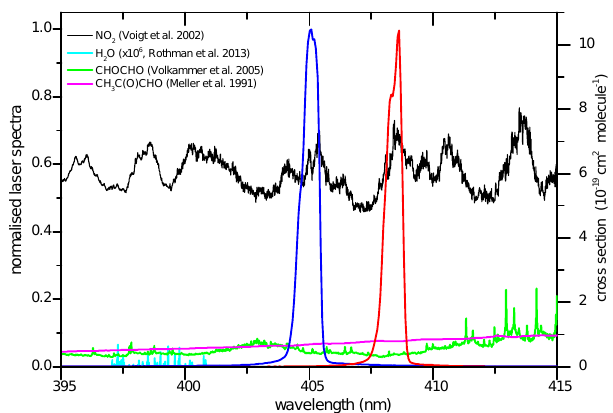
Figure 2. Laser emission spectrum (left y axis) measured in the ref- erence cavity (blue) and the TD cavity (red). The absorption spec- tra (Meller et al., 1991; Voigt et al., 2002; Volkamer et al., 2005b; Rothman et al., 2013) are associated with the right y axis. The H 2 O spectrum is scaled by a factor of 1 × 10 6